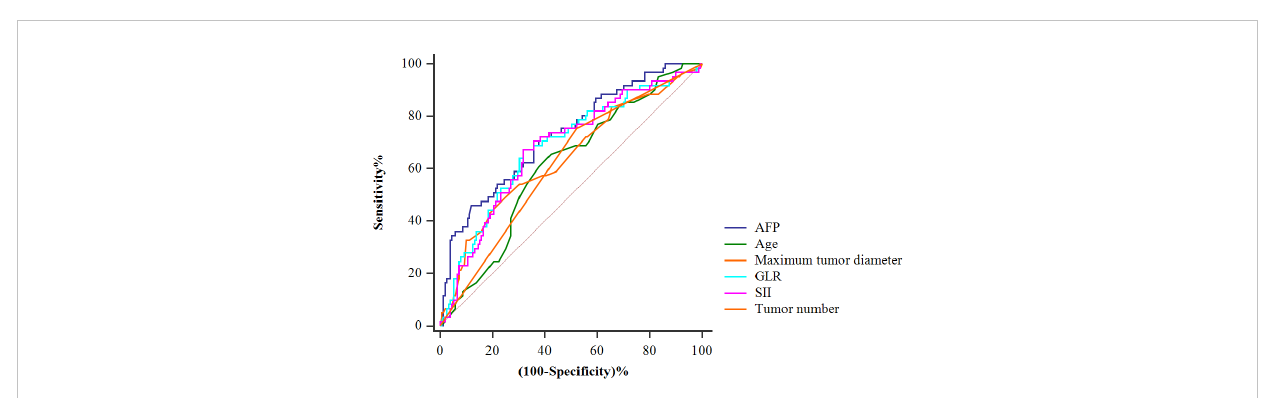
FIGURE 2 Receiver-operating characteristic curves for tumor recurrence of the AFP, age, maximum tumor diameter, tumor number, GLR, and SII.